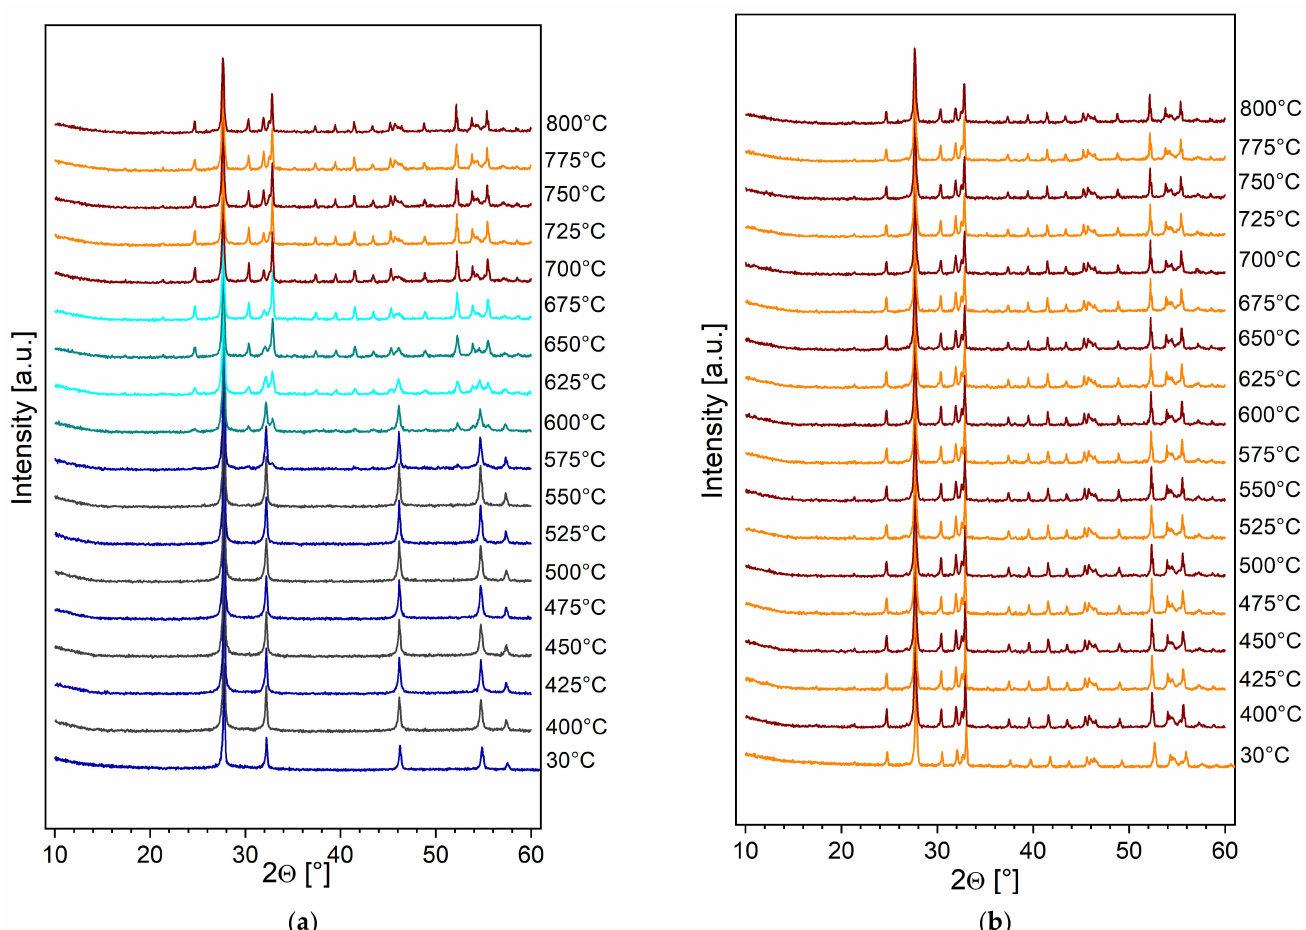
Figure 3. ( a ) Thermal evolution of XRD patterns of a sample prepared in ceramic crucible at 1000 ◦ C and quenched by twin rollers method (1000 RPM) during heating up to 800 ◦ C; ( b ) thermal evolution of the same sample during cooling down from 800 ◦ C to room temperature. Blue and gray colors correspond to δ -Bi 2 O 3 type phase (fluorite structure); turquoise color indicates phase transition to γ -like phase; orange and maroon colors correspond to γ -like phase stability